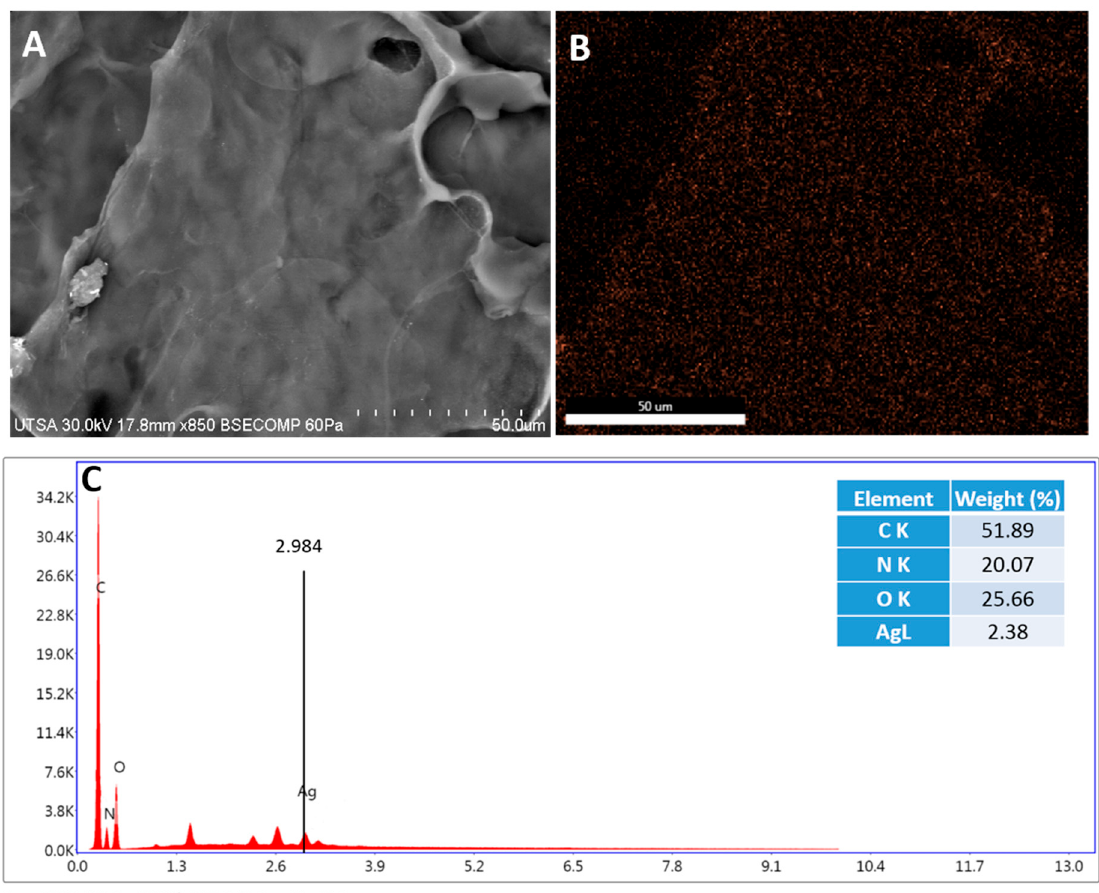
Figure 2. Radiosterilized porcine skin dermis shows a homogeneous distribution of silver nanopar- ticles. ( A ) SEM image of the dermis; ( B ) EDS mapping of the dermis, orange dots represent the distribution of Ag; and ( C ) analysis of elements expressed as the percentage of elements on the dermis performed by EDS mapping.